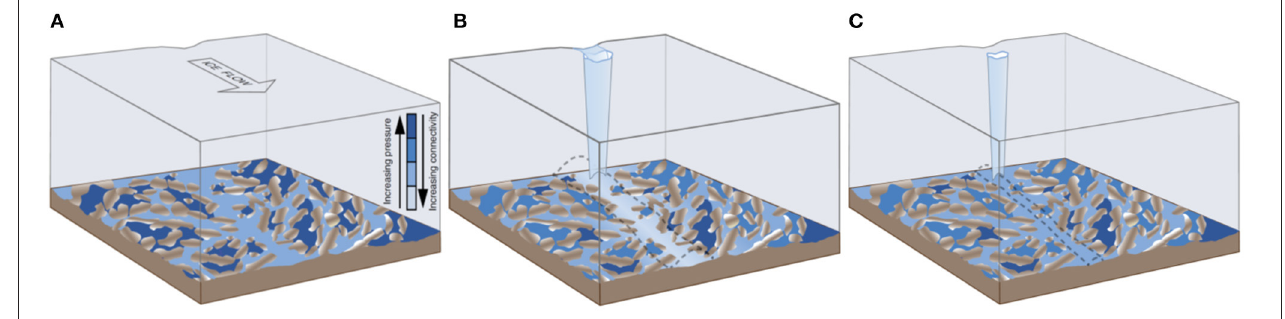
FIGURE 7 | Conceptual model of ice flow self-regulation by the inactive subglacial drainage system. (A) At the onset of the melt season, a large fraction of the bed is comprised of high pressure, weakly connected cavities. (B) By the middle of the melt season, efficient subglacial drainage has developed (dashed grey outline) and the extent and pressure of the inactive system have decreased, leading to relative ice flow slow-down. (C) At the end of the melt season, channels collapse soon after surface melt cessation and water pressure in the inactive drainage system begins to increase, leading to gradual ice flow speed-up. Adapted from Hoffman et al.